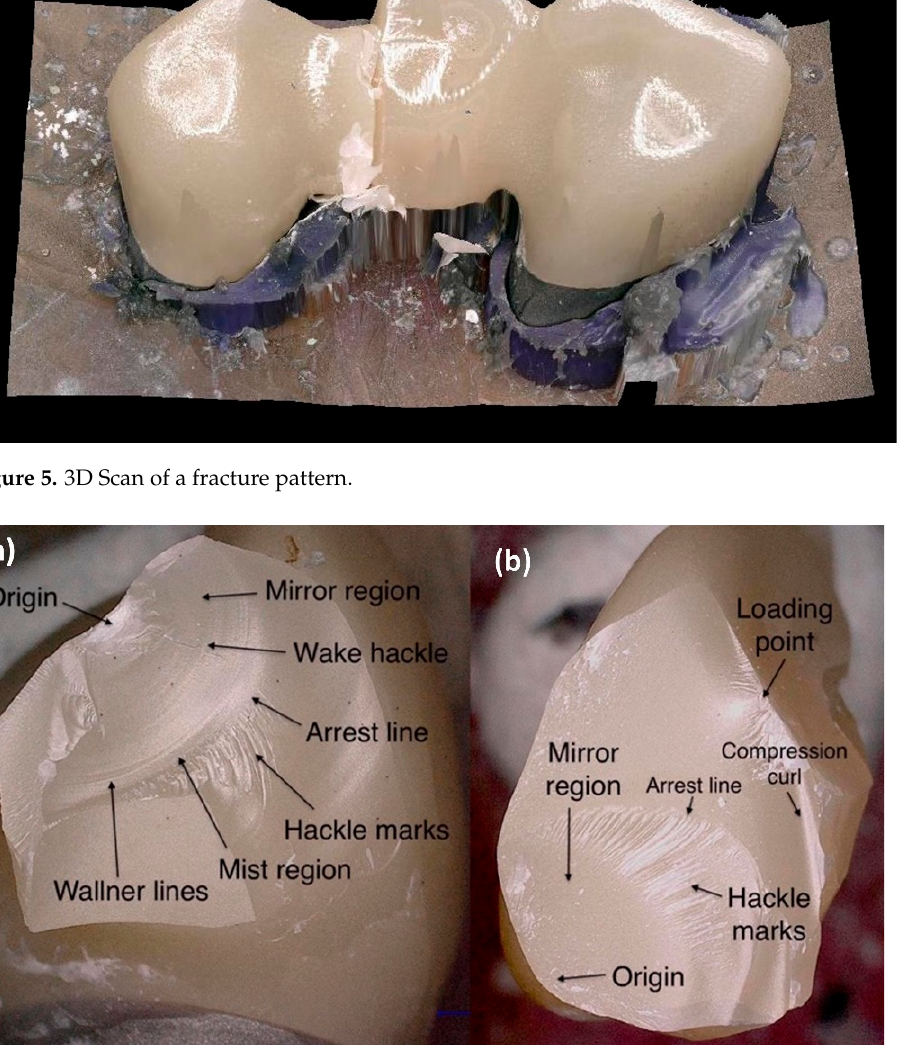
Figure 6. Fractographic analysis: ( a ) fracture origin near the loading point. This fracture type usually occurs with HTML and YML; ( b ) fracture origin on the gingival side of the pontic. This fracture type usually occurs with STML and UTML.